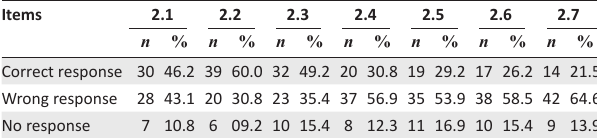
TABLE 1: Frequency of Correct, Wrong and No responses for items in the